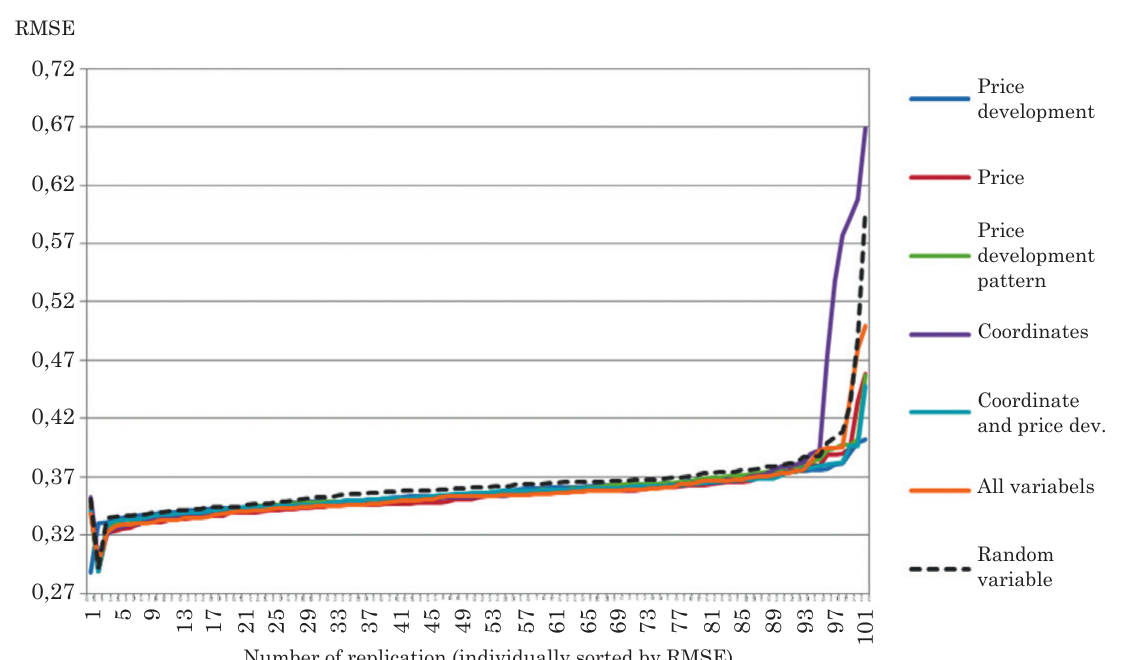
Figure 8. Resembles Figure 6, but in the extreme replications the RMSE is